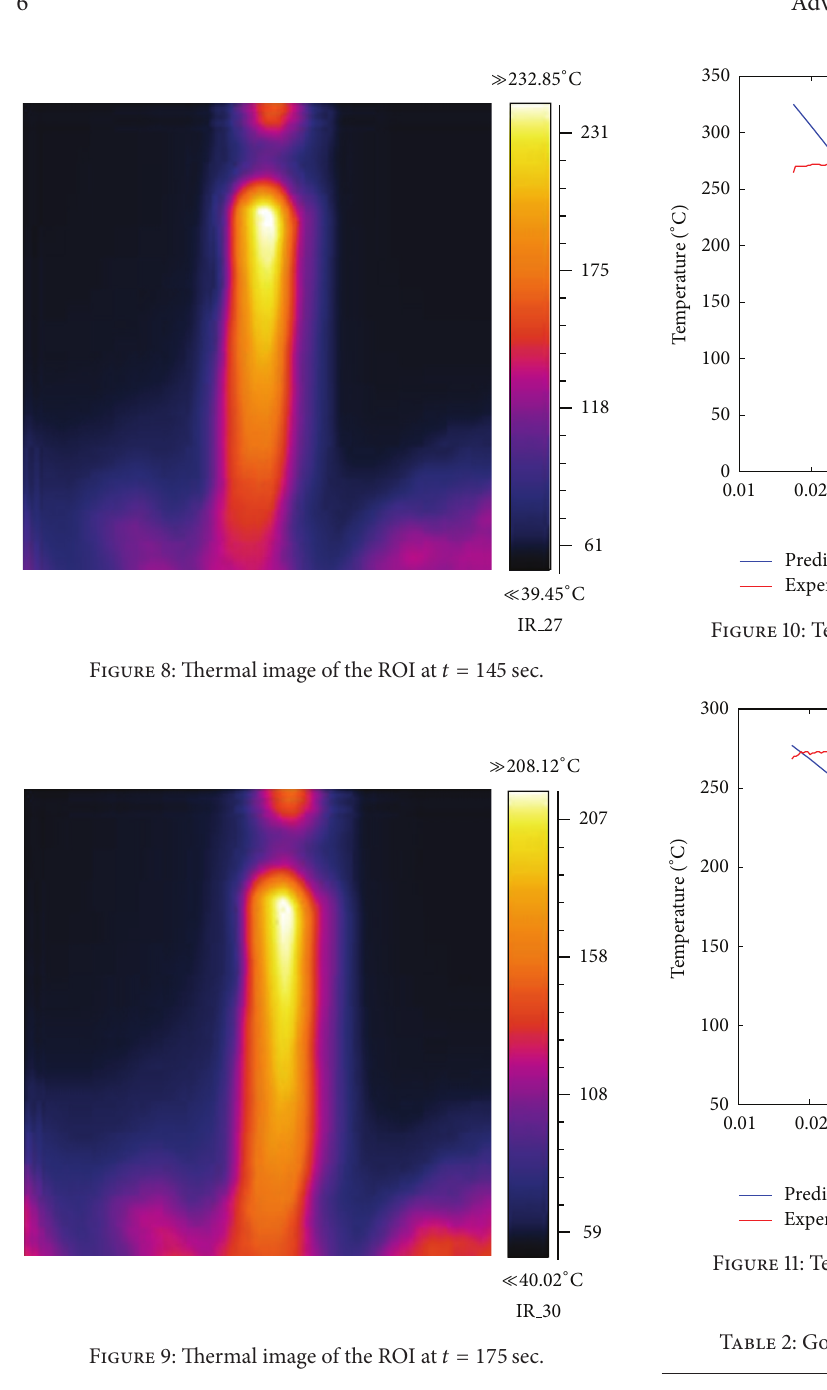
profile obtained from ANSYS simulation was plotted with the temperature profile obtained experimentally for comparison.